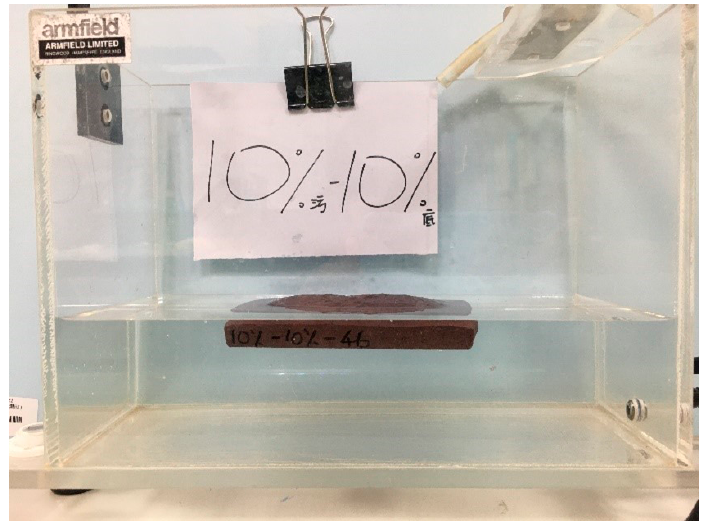
Figure A1. Floating tile specimen (10% MIBA and 10% SSA sintered at 1150 °C)